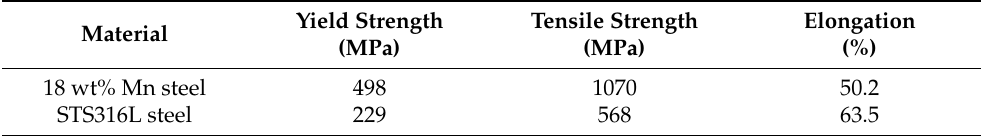
Table 2. Mechanical properties of supplied steels at room